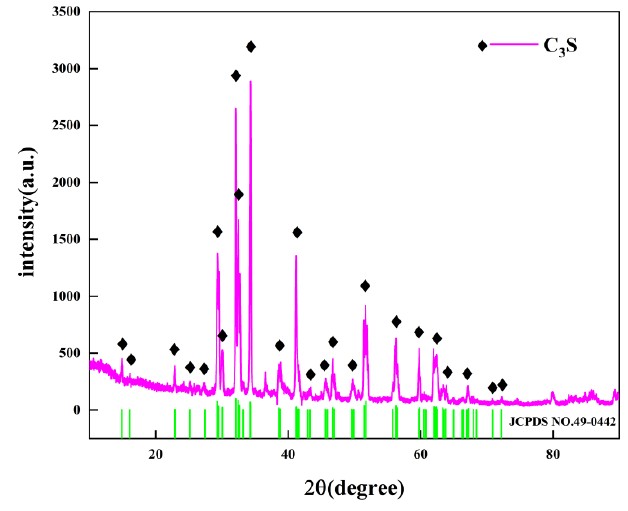
Figure 1. XRD pattern of C 3 S.